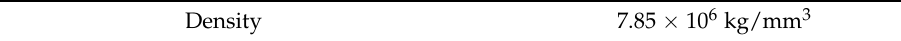
Table 1. Structural steel’s constants by FEM (Ansys Workbench).